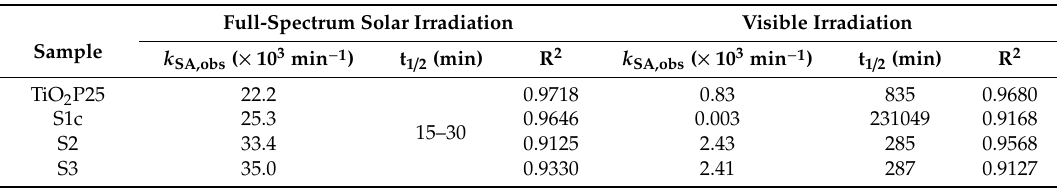
Table 2. The pseudo-first order rate constant (k SA,obs ) for the degradation of SA in the flow cell irradiated with simulated solar and visible